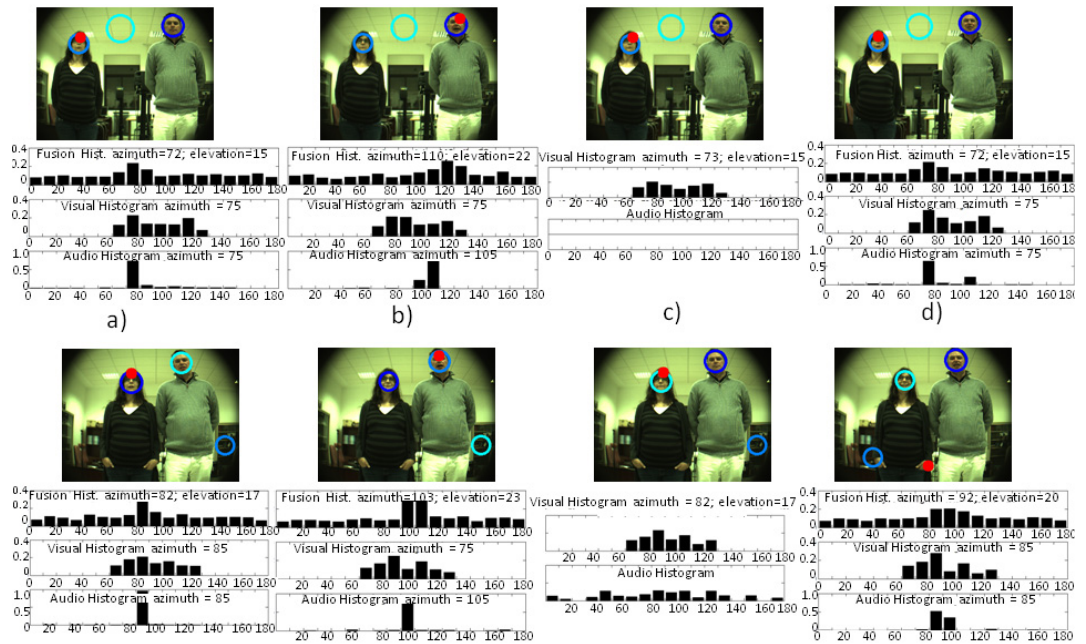
Figure 10. Results obtained with two speakers placed at two different distances between them. ( a ) The person on the left talking. ( b ) The person on the right talking. ( c ) None of the people talking. ( d ) Two people talking simultaneously. The multimodal sensor estimation is marked with a red circle. Blue circumferences show OpenCV face-detector